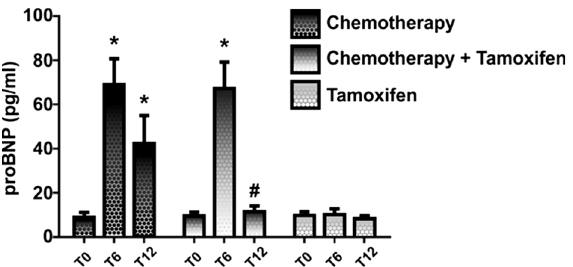
Figure 2. Plasma concentrations of pro-B-type natriuretic peptide (proBNP) in the groups treated with chemotherapy alone, chemotherapy followed by tamoxifen, and tamoxifen alone. Data are reported as means±SD. *P , 0.01 compared to T0; # P , 0.01 compared to T6 (Bonferroni test).